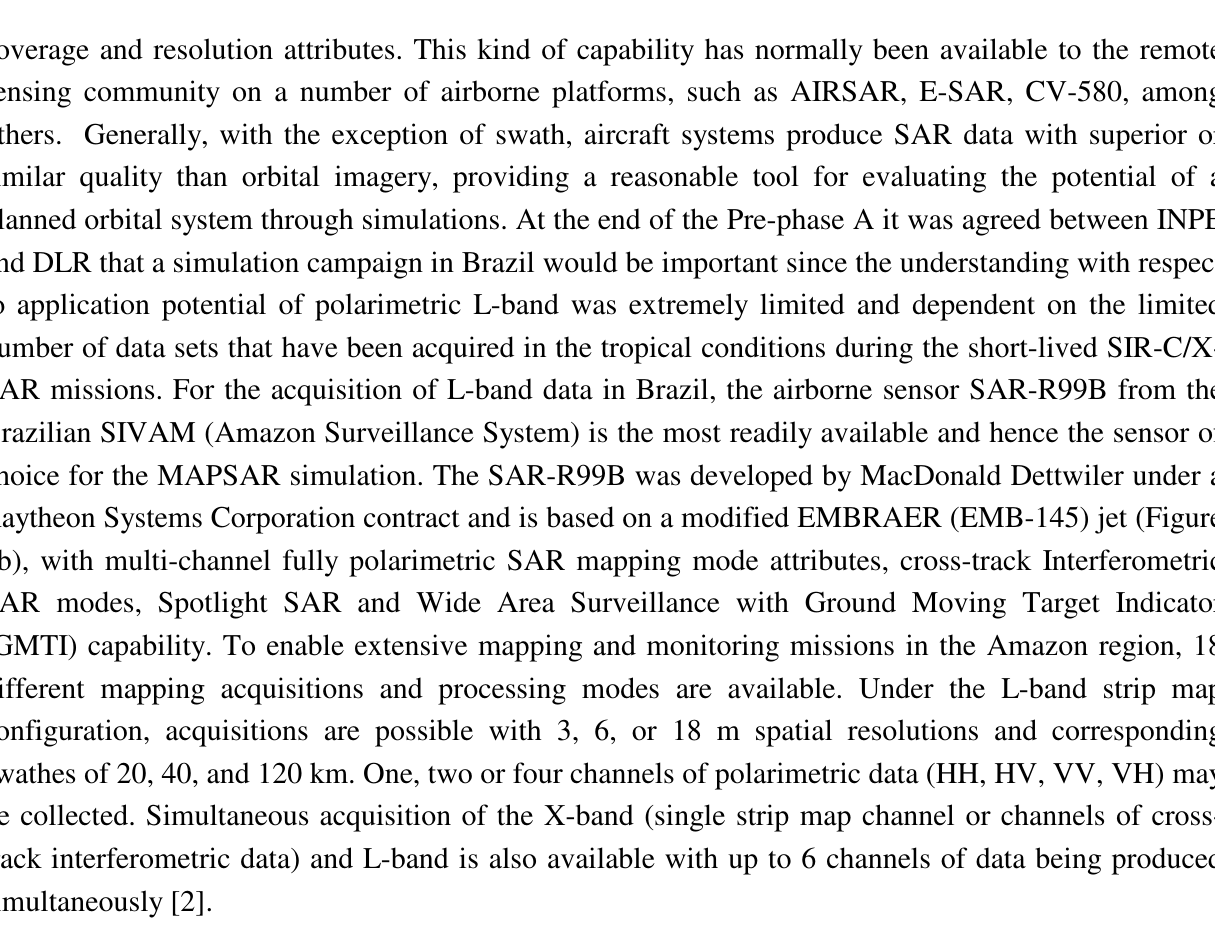
Figure 1. (a) MAPSAR satellite conception; (b) SAR-R99B on board of the EMB-145